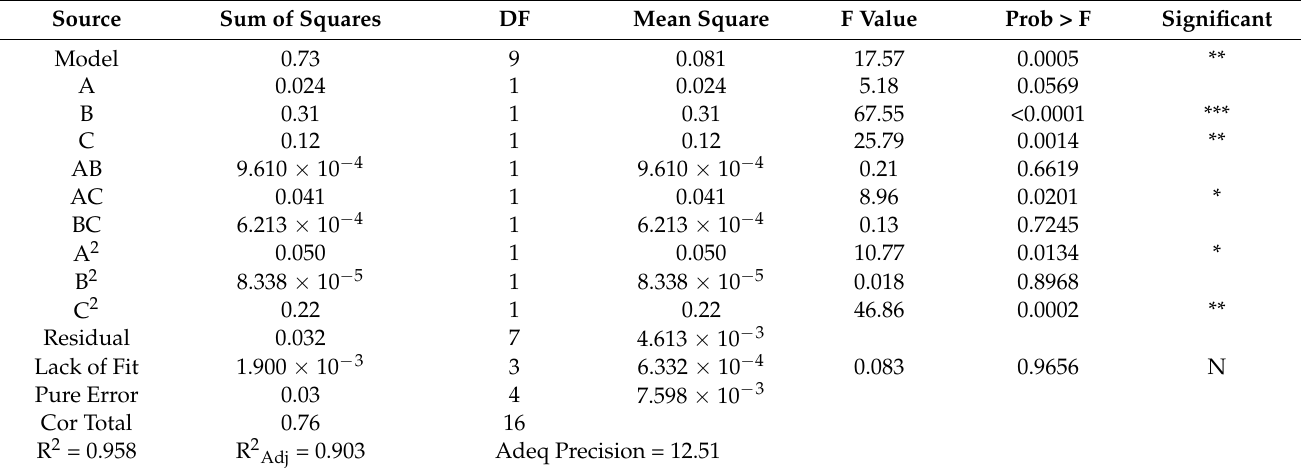
Table A2. Analysis of variance (ANOVA) for the response surface quadratic